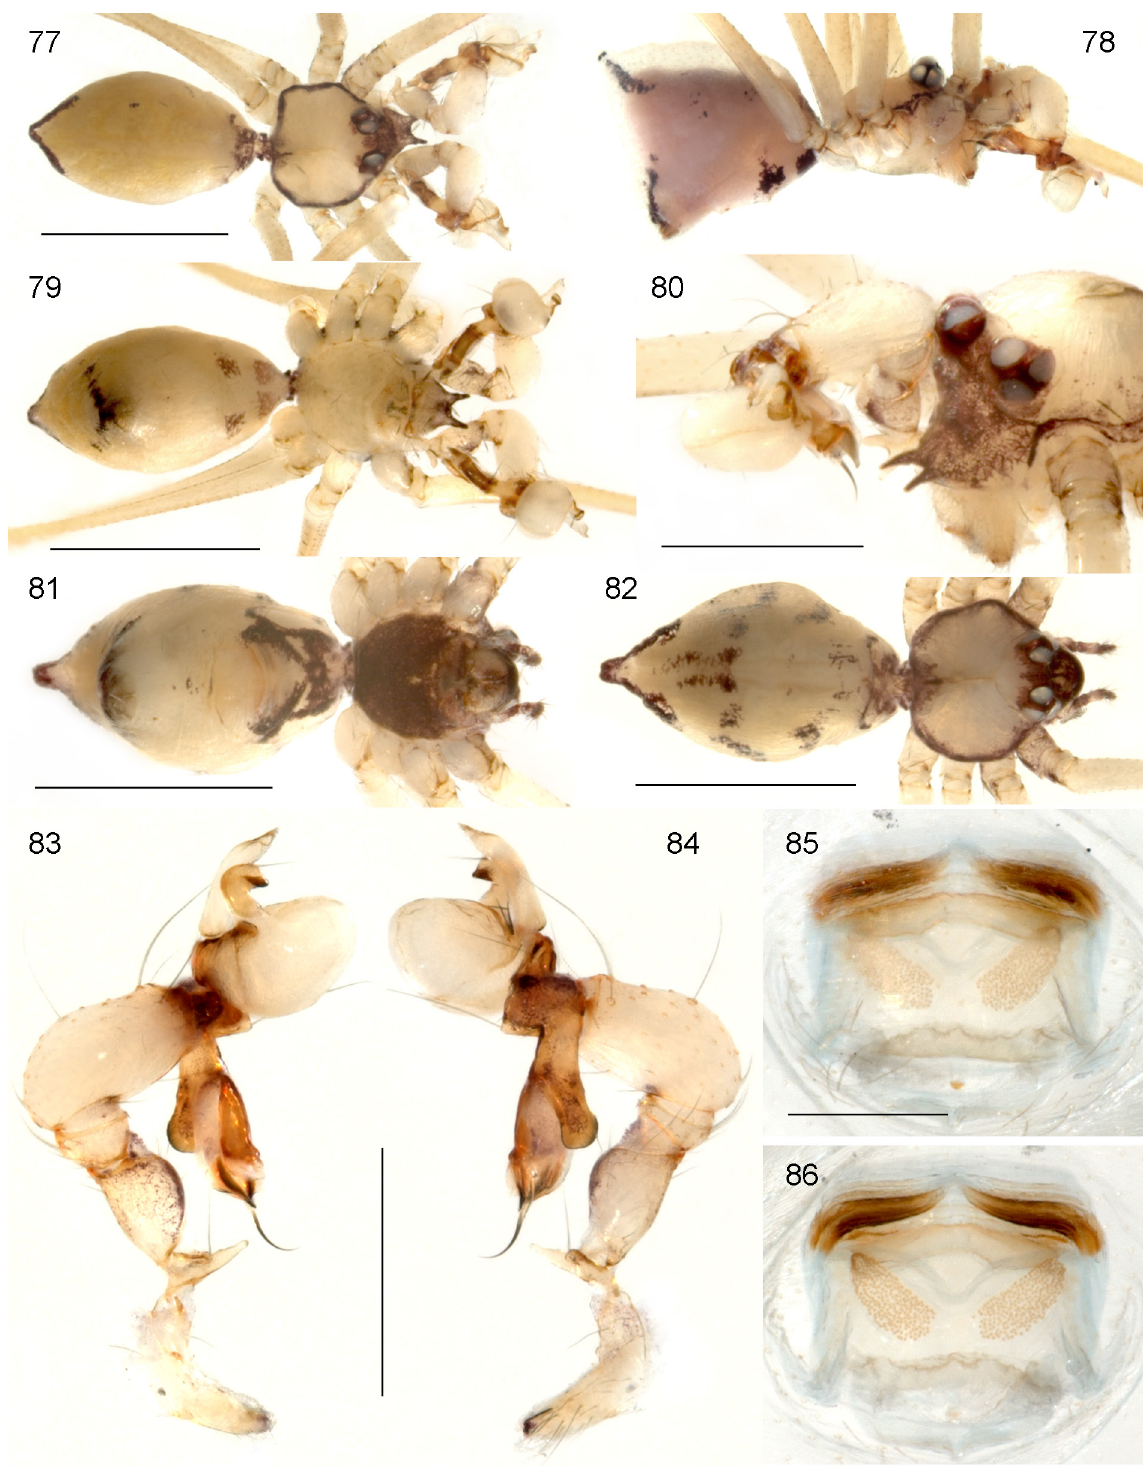
Figs 77-86. Spermophora akwamu sp. nov. 77-79 . ♂, dorsal, lateral, and ventral views. 80 . ♂ prosoma, oblique frontal view. 81-82 . ♀, ventral and dorsal views. 83-84 . Left ♂ palp, prolateral and retrolateral views. 85-86 . Cleared ♀ genitalia, ventral and dorsal views. Scale lines: 77-79, 81-82 = 1 mm; 80, 83- 84 = 0.5 mm; 85-86 = 0.2